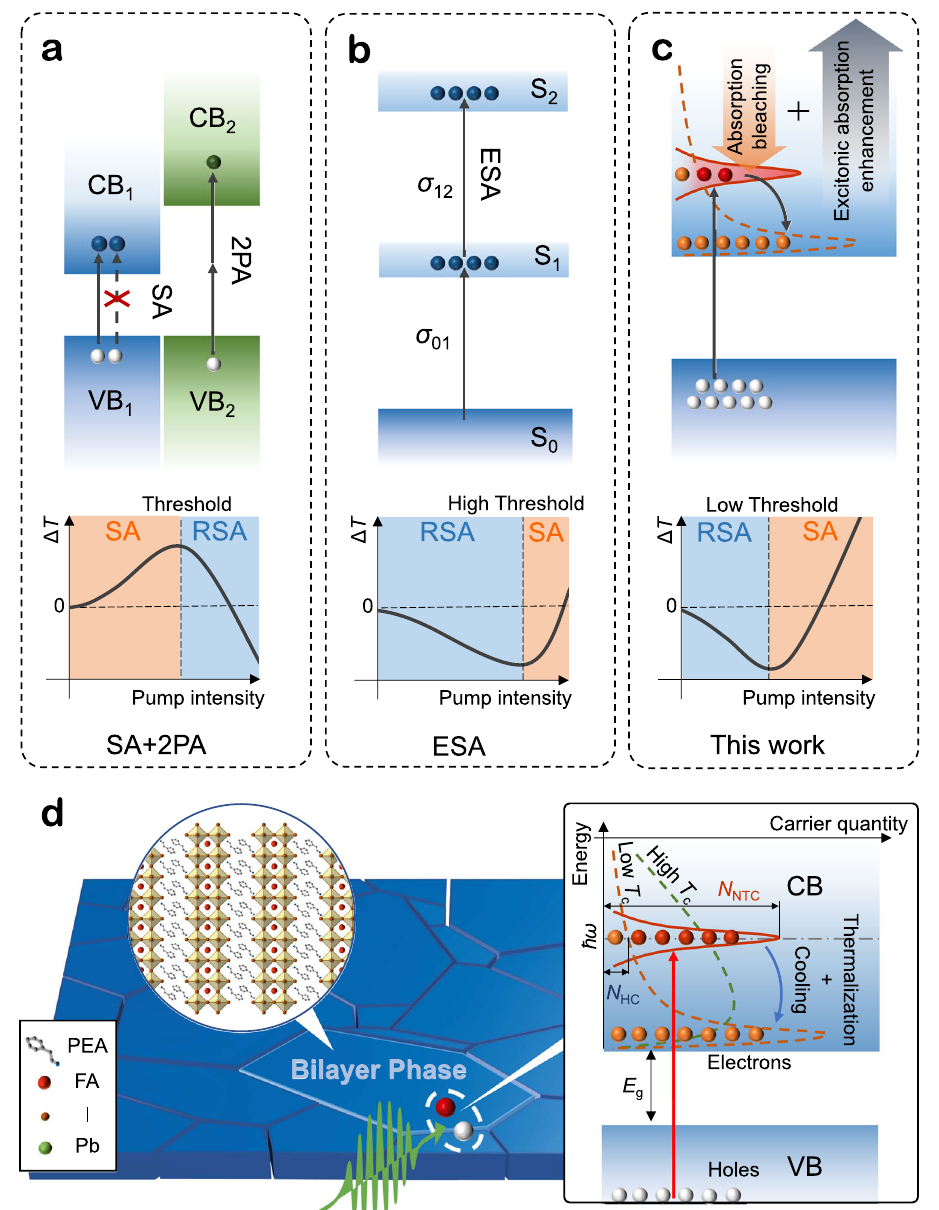
Fig. 1 | Nonlinear absorption switching mechanism. a Schematics of NLA switching in conventional inorganic semiconductors (top) and the corresponding NLA evolution as a function of pump intensity (bottom), according to standard SA and RSA, where the RSA can stem from two-photon absorption (2PA). CB and VB denote conduction band and valence band respectively. Δ T denotes the NLA induced transmittance difference. b NLA of organic molecules based on excited state absorption (ESA) leading to an inverse transition from RSA to SA. S 0-2 repre- sent the separated energylevel. σ is the absorption cross-section. c NLAprocess of quasi-2D (PEA) 2 FAPb 2 I 7 perovskite fi lm in our work, where the competition betweennon-thermalizedcarrierinducedbleachingandmany-bodyeffectinduced excitonic absorption enhancement results in a conversion from RSA to SA. d Schematic of the initial carrier evolution process in deposited quasi-2D